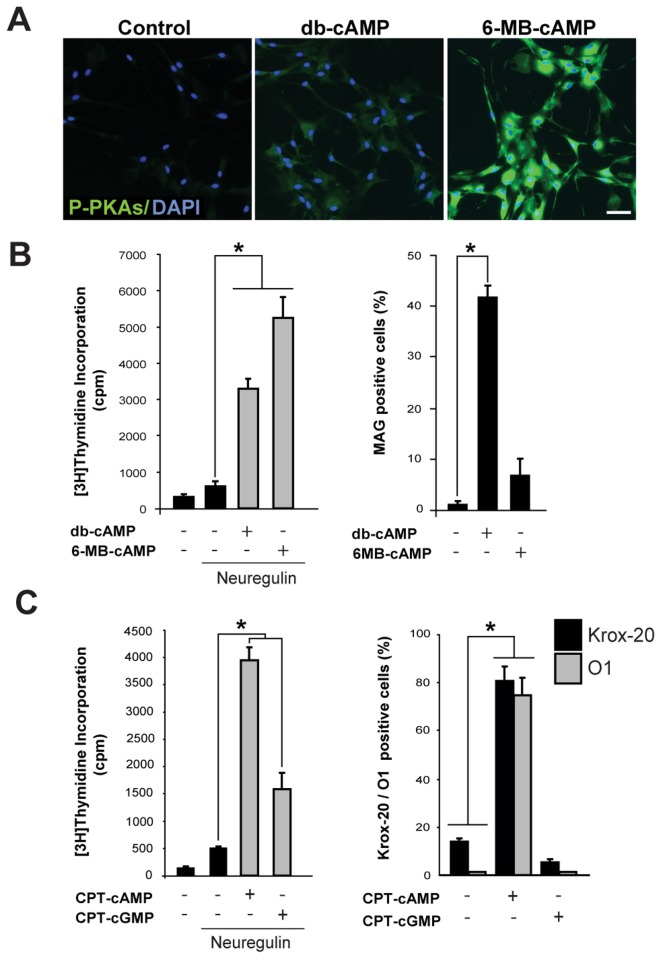
Effect of selective and non-selective activation of PKA on the proliferation and differentiation of isolated SCs.The assessment of PKA activity (A), S-phase entry (B-C, left panels) and differentiation (B-C, right panels) was done essentially as described in Figure 1. A quantitative data analysis of immunofluorescence microscopy images is presented in B, C (right panels). In A-B, the relative activities of non-selective (db-cAMP) and PKA-selective (6-MB-cAMP) analogs are compared in SCs stimulated for 30 min (A) and 3 days (B), respectively. db-cAMP and CPT-cAMP were used as positive controls for the induction of PKA activity (A), proliferation and differentiation (B-C). All analogs were used at a concentration of 200 µM.